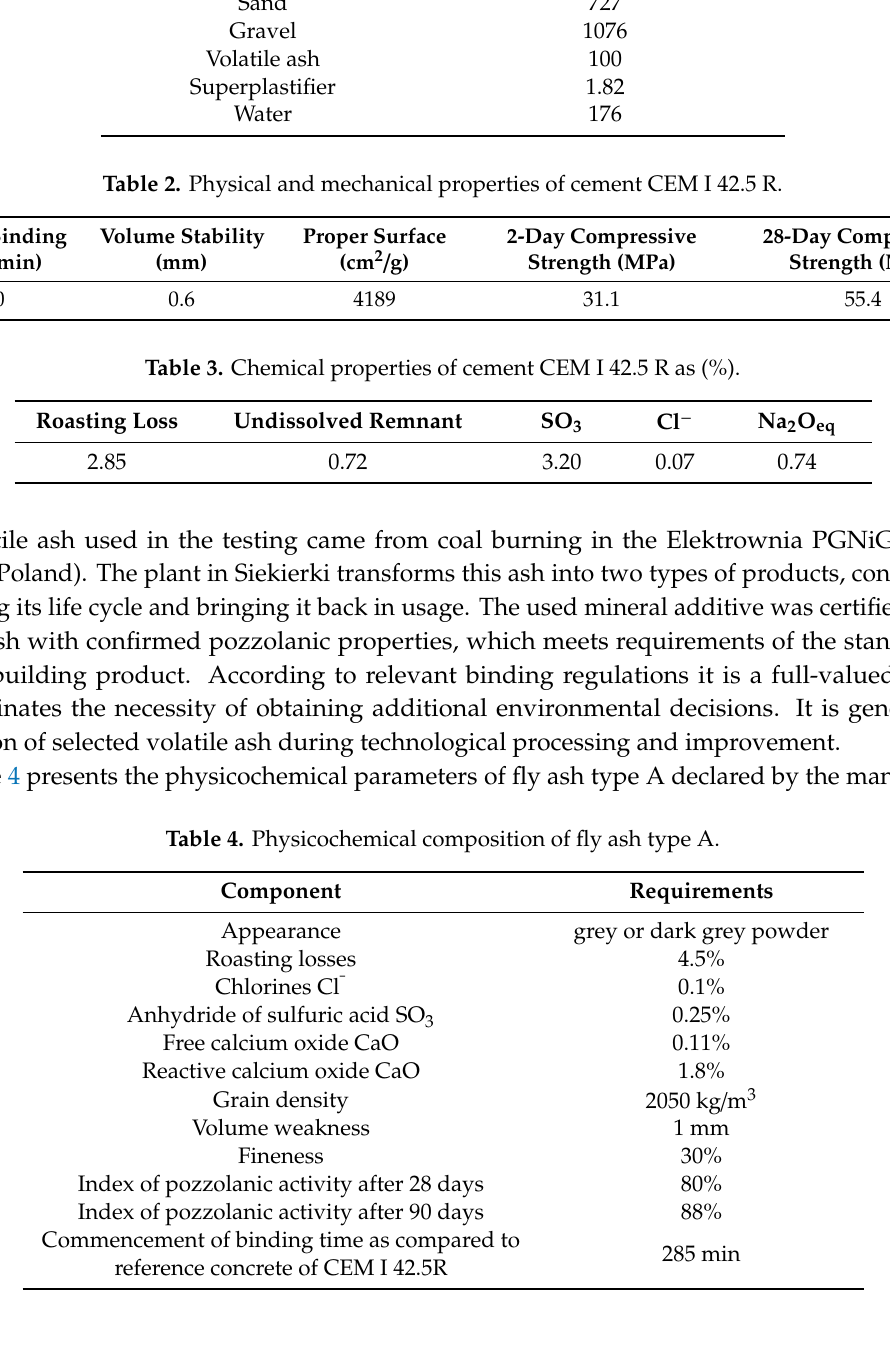
(Table 1): CEM I 42.5 R universal cement (Cement O˙zar ó w S.A., O˙zar ó w, Poland), aggregate, cat. A volatile ash (Zakład Separacji Popioł ó w Siekierki Sp. z o.o., Warszawa, Poland), superplastifier